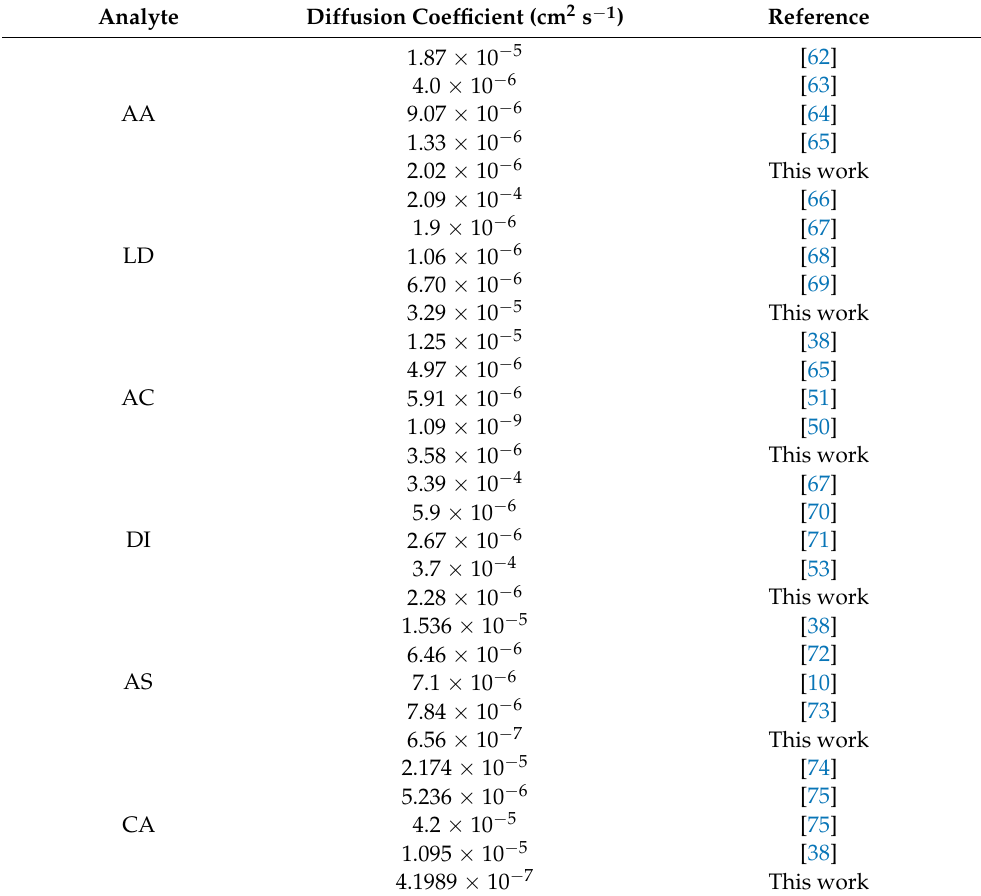
Table 3. Summary of the calculated diffusion coefficients ( D ) and the comparison to previously reported values using various modified